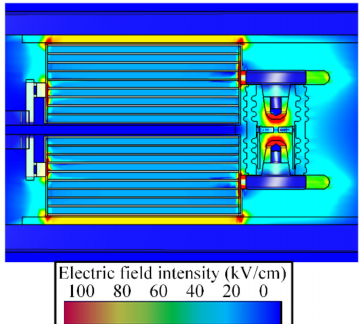
Figure 12. Cross-sectional view of magnitude of electric field intensity distribution of the discharging brick when initially charged.